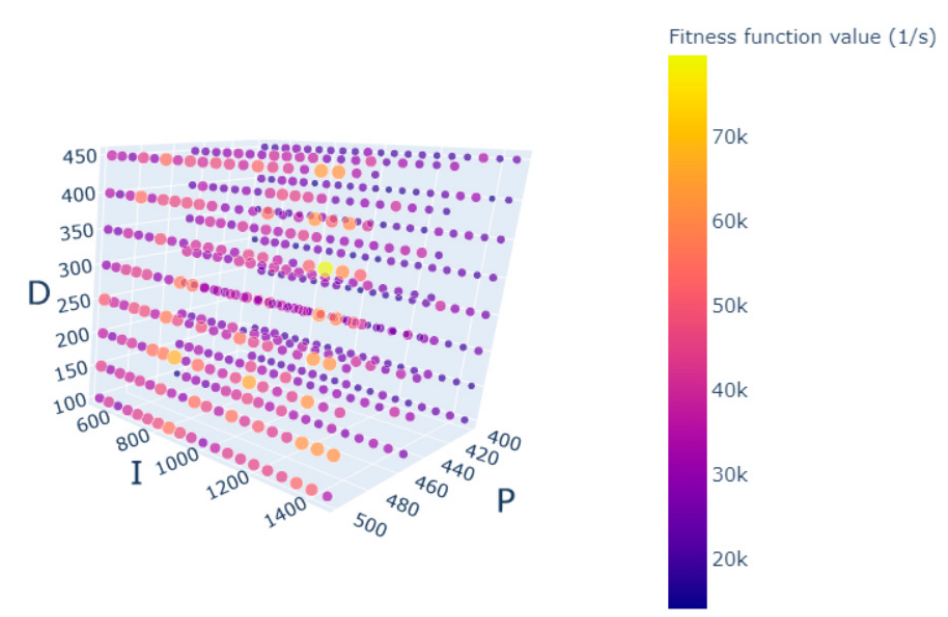
one-fifth of the value achieved with the DSDF driving method (see Figure 11). Figure 10. Grid search with fitness function values for the velocity of 0.1 ◦ /s and DSDF source driving. Figure 10. Grid search with fitness function values for the velocity of 0.1 °/s and DSDF source driving.